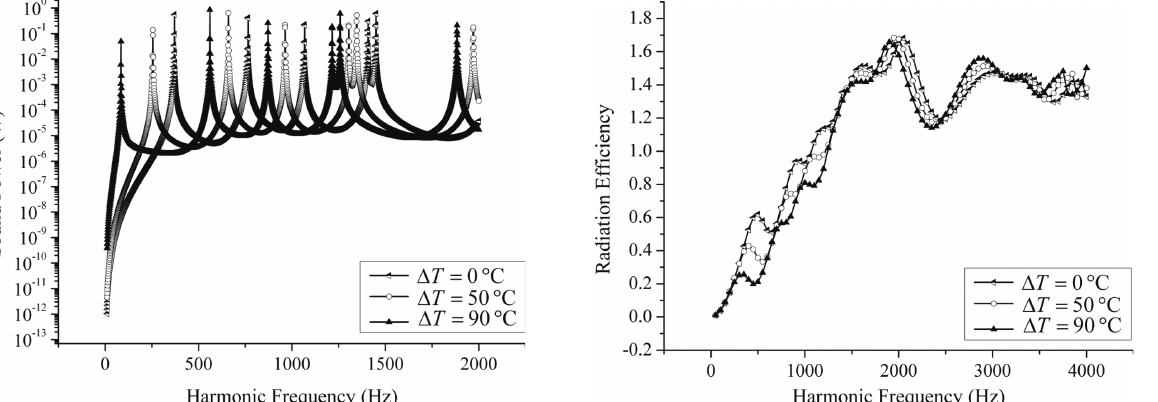
Fig. 13. Sound power. Fig. 14. Radiation efficiency.